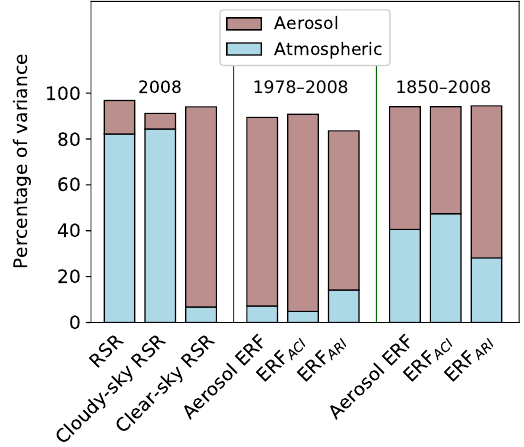
Figure 9. The relative contributions from atmospheric and aerosol parameters to variance in ToA radiative fluxes and aerosol effective radiative forcing over the 1978–2008 and 1850–2008 periods.